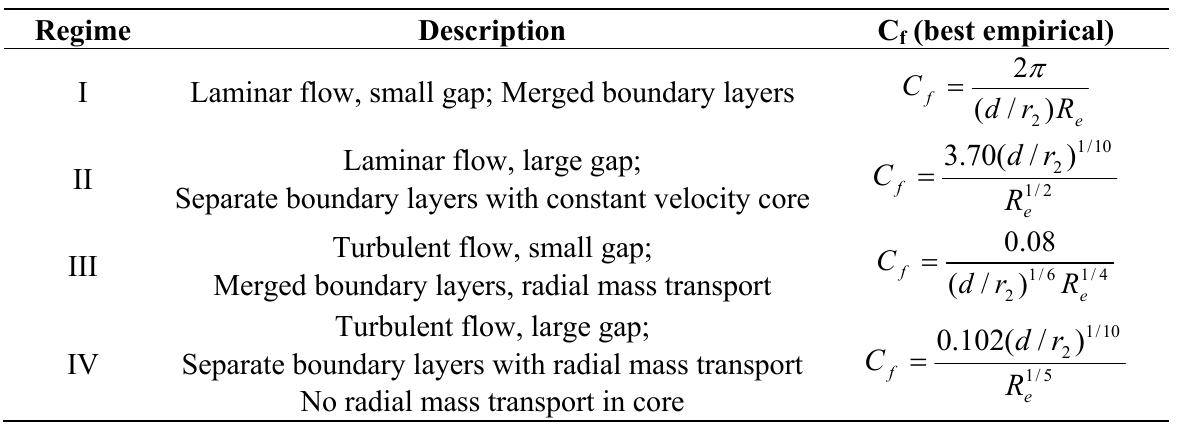
Table 5. Overview of the possible flow configurations that may occur when a disc rotates inside a cylindrical